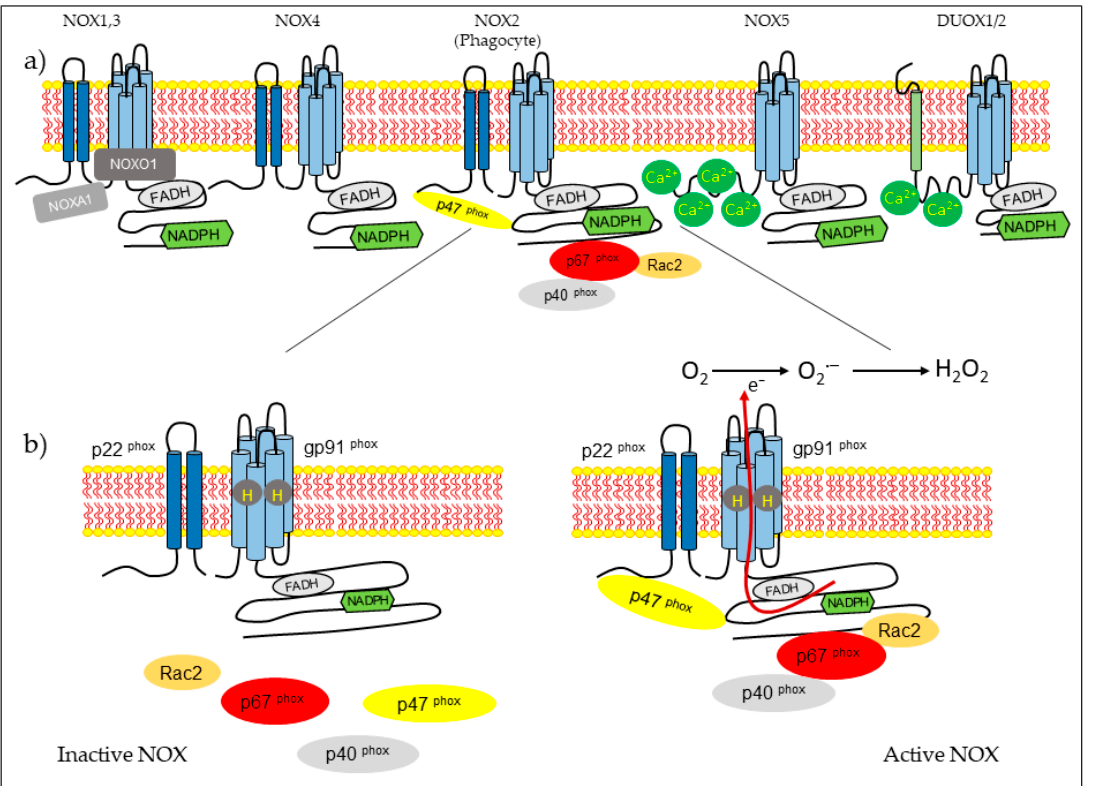
Figure 1. NADPH oxidase (NOX) types and activation of the NOX2 macrophage for the formation of reactive oxygen species. ( a ) Structure of the isoforms that are part of the NOX family. ( b ) Activation of the NOX2 system, which occurs by the assembly of cytosolic regulatory proteins (p40 phox , p47 phox , p67 phox , and Rac2) with the catalytic subunit gp91 phox and p22 phox in the membrane, to activate the enzyme complex and generate superoxide anions (O 2 − ) and hydrogen peroxide (H 2 O 2 ). The other isoforms share some characteristics of NOX2 activation. The NOX1 isoform exhibits 60% of its identity with NOX2. Its activity depends on cytosolic subunits. NOX1 requires p22 phox , Rac GTPase, the first organizer (NOXO1), which is a homolog of p47 phox , and the first activator (NOXA1), a homolog of p67 phox [34]. NOX3 shares 56% of its amino acid identity with NOX2 [35]. This NOX requires NOXO1 and NOXA1 for activation, but p47 phox , p67 phox , and Rac have not been studied [36]. NOX4 shares approximately 39% of it sequence homology with NOX2. This isoform is constitutively